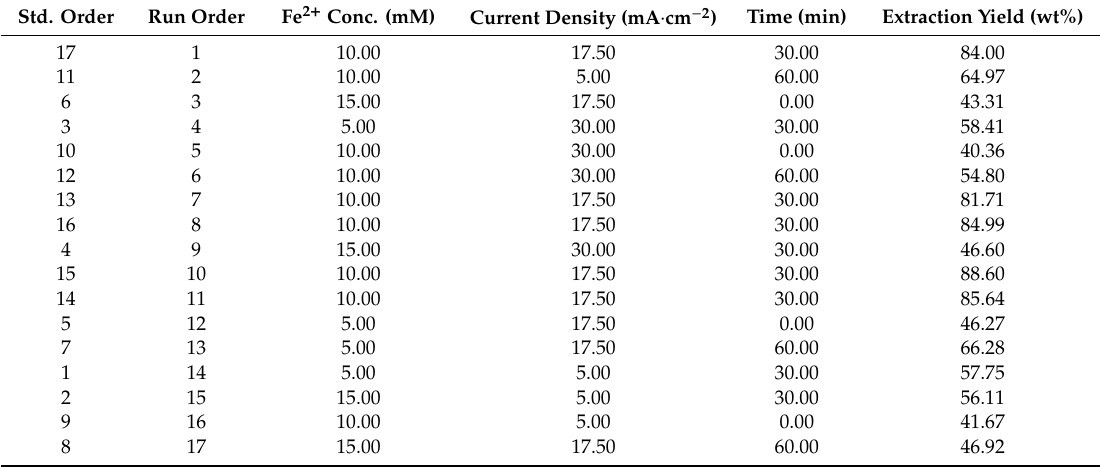
Table 1. Experimental design matrix for the optimization of electro-Fenton